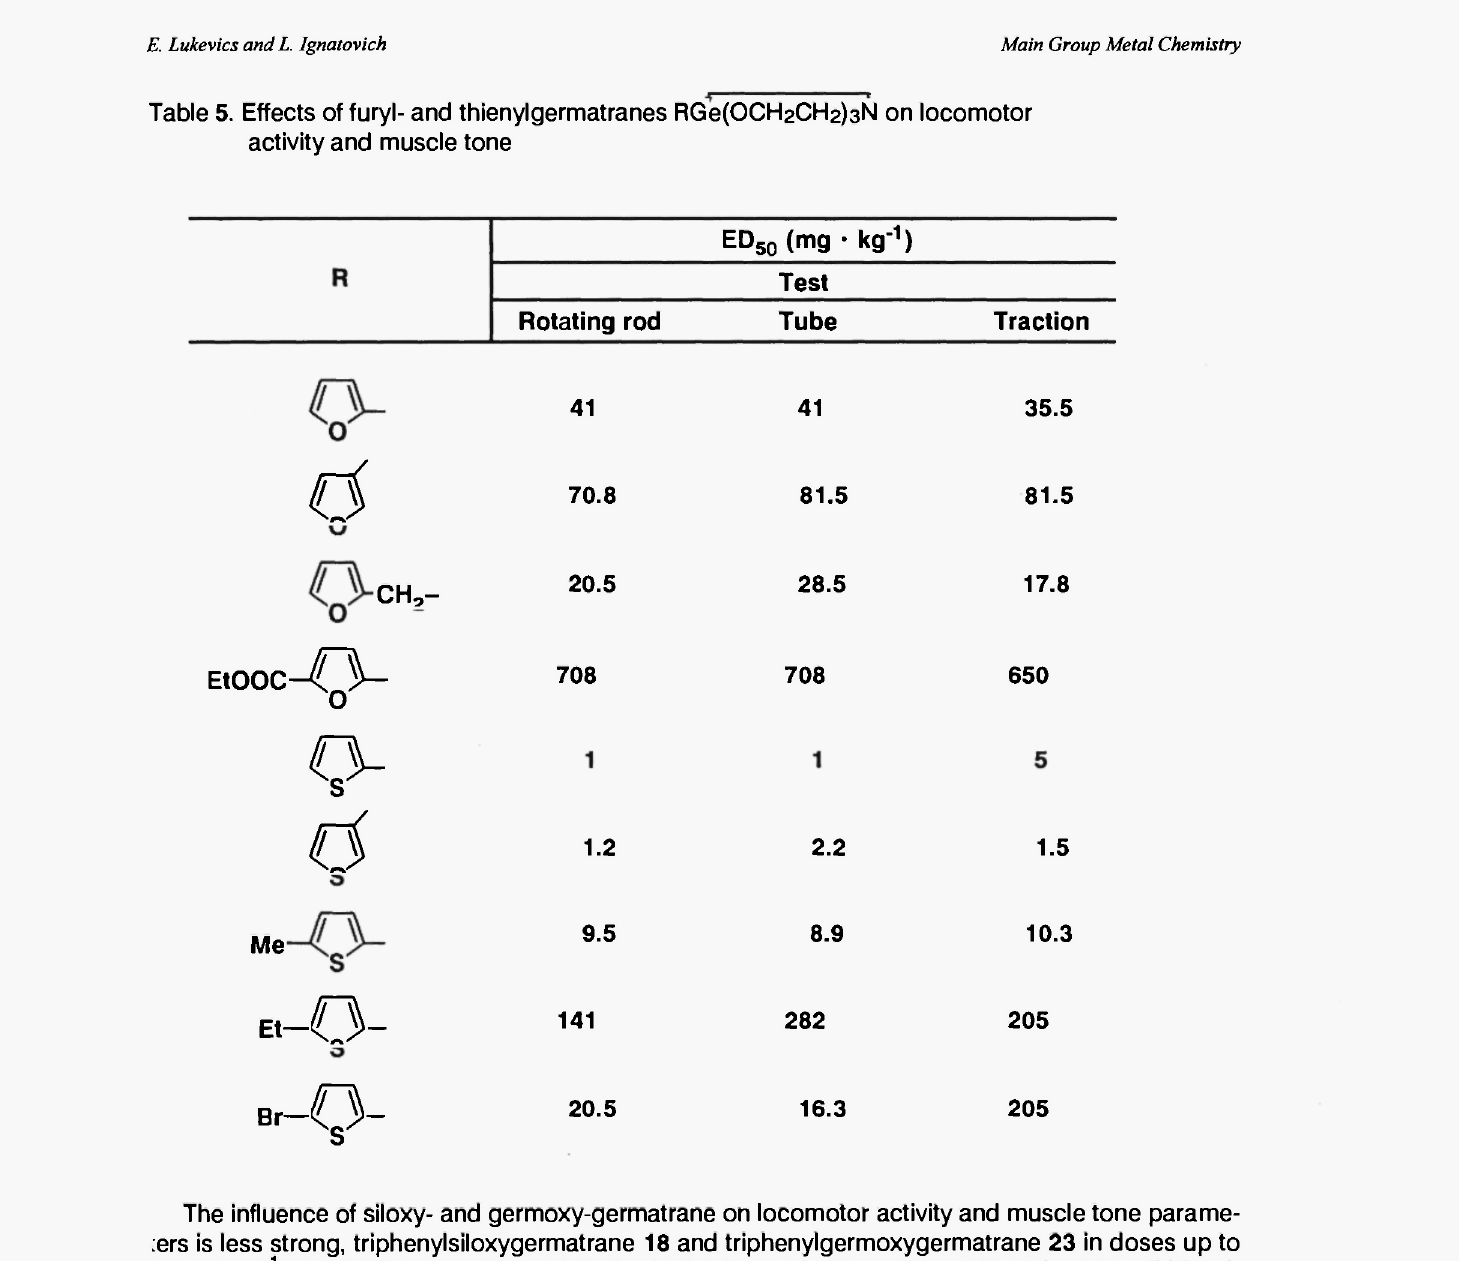
Table 5. Effects of furyl- and thienylgermatranes RGe(OCH2CH2)3N on